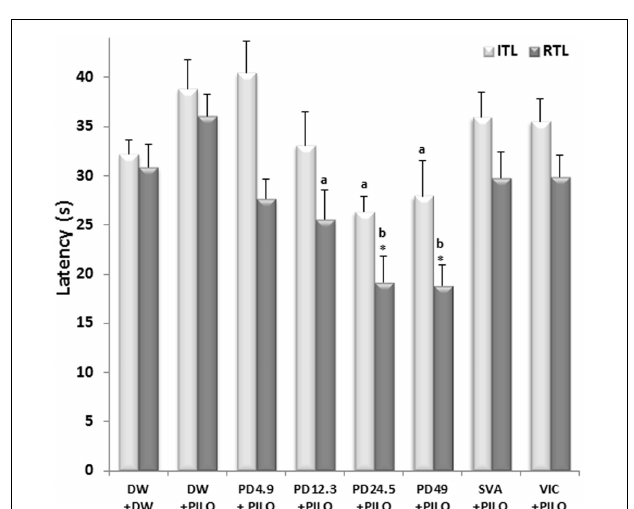
FIGURE 2 | Effects of P. daemia on elevated plus maze parameters. Data are mean ± SEM, N = 7 per group. Newman Keul’s multiple comparisons post hoc test, with Mann–Whitney U test correction: (i) vs. control animals (DW + DW group) receiving only distilled water: ∗ p < 0.05; (ii) vs. disease control animals (DW + PILO group) receiving distilled water and pilocarpine: a p < 0.05, b p < 0.01. DW, distilled water; PD, Pergularia daemia ; PILO, pilocarpine; VIC, vitamin C; SVA, sodium valproate; ITL, initial transfer latency; RTL, retention transfer latency.